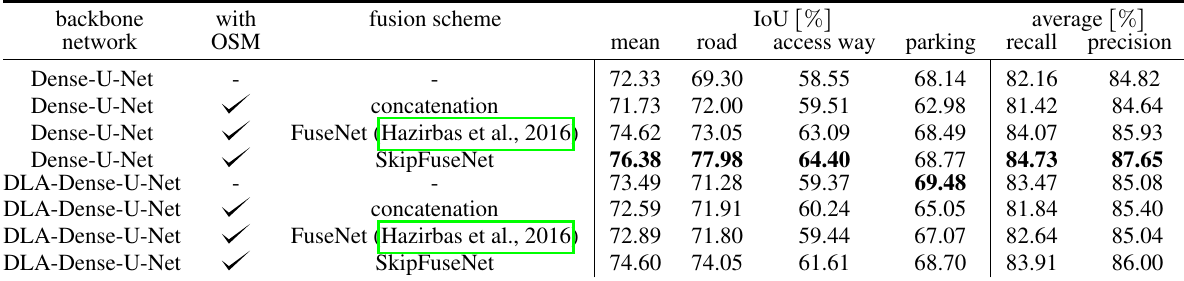
Table 1. Performance comparison of the Dense-U-Net and DLA-Dense-U-Net architectures using different OSM fusion methods.